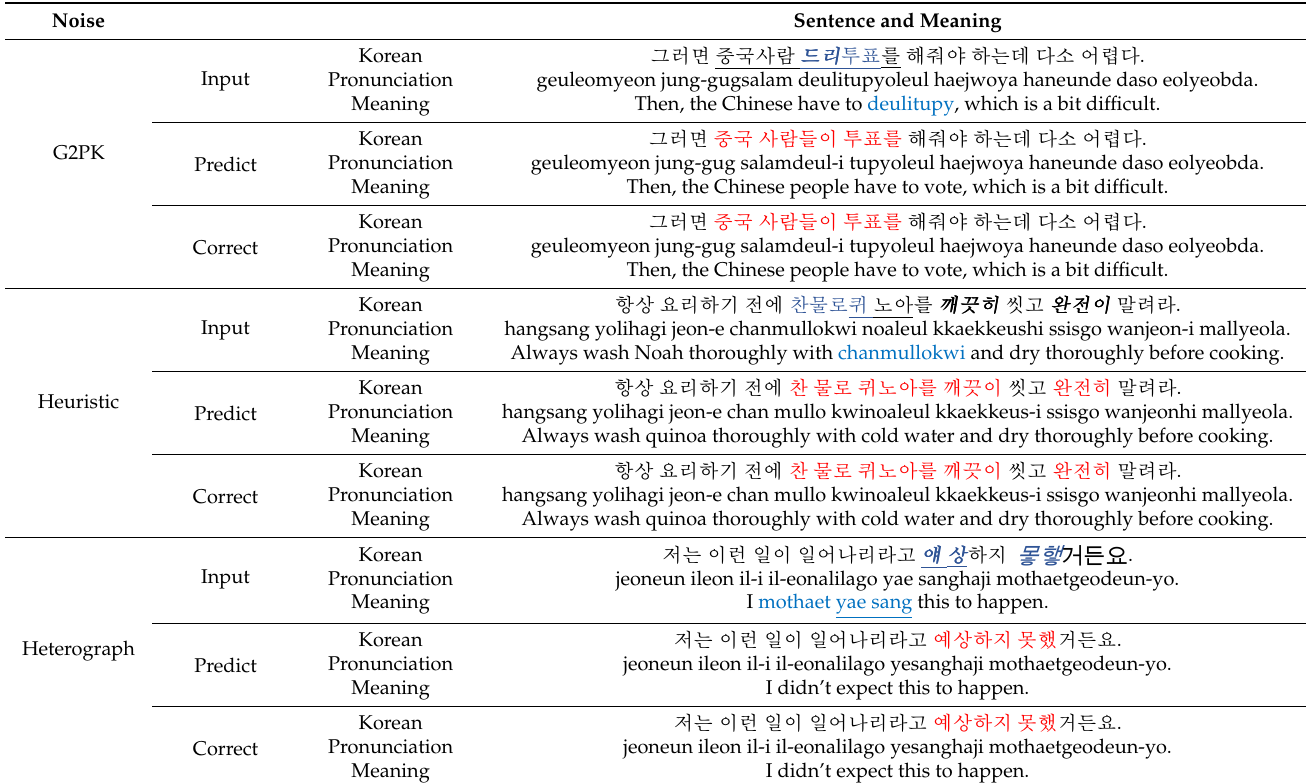
Table 12. Example of Output of Transformer with Copying Mechanism for each Noising Method.